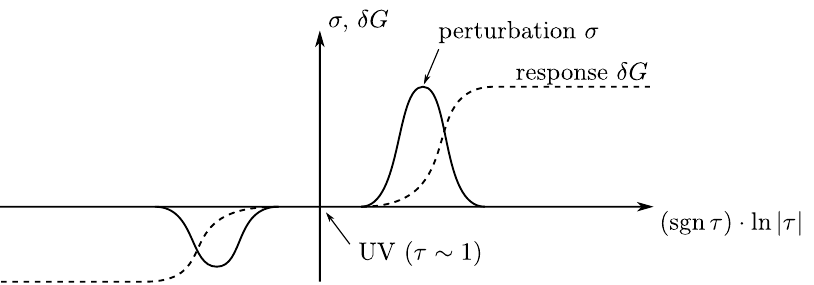
Figure 2. RG (cid:13)ow of a perturbation (cid:27) (solid line), generating the response (cid:14)G (dashed line) at larger time